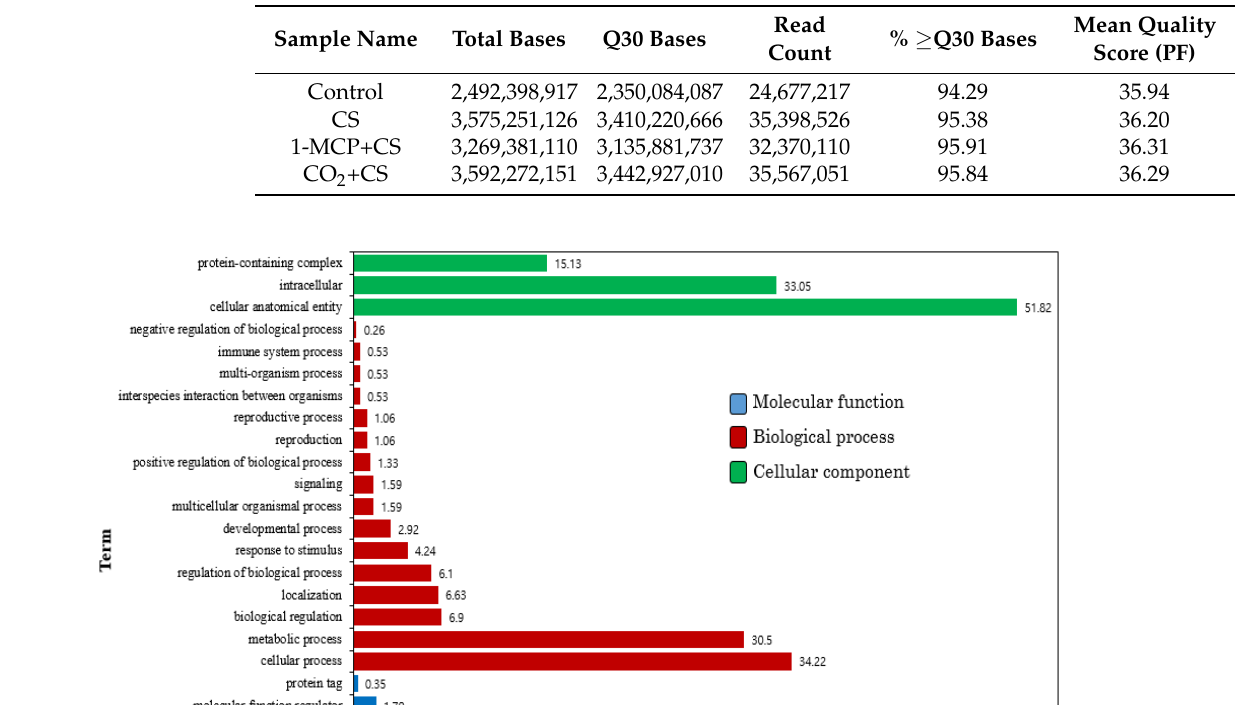
Table 2. Summary of the average sequencing result.